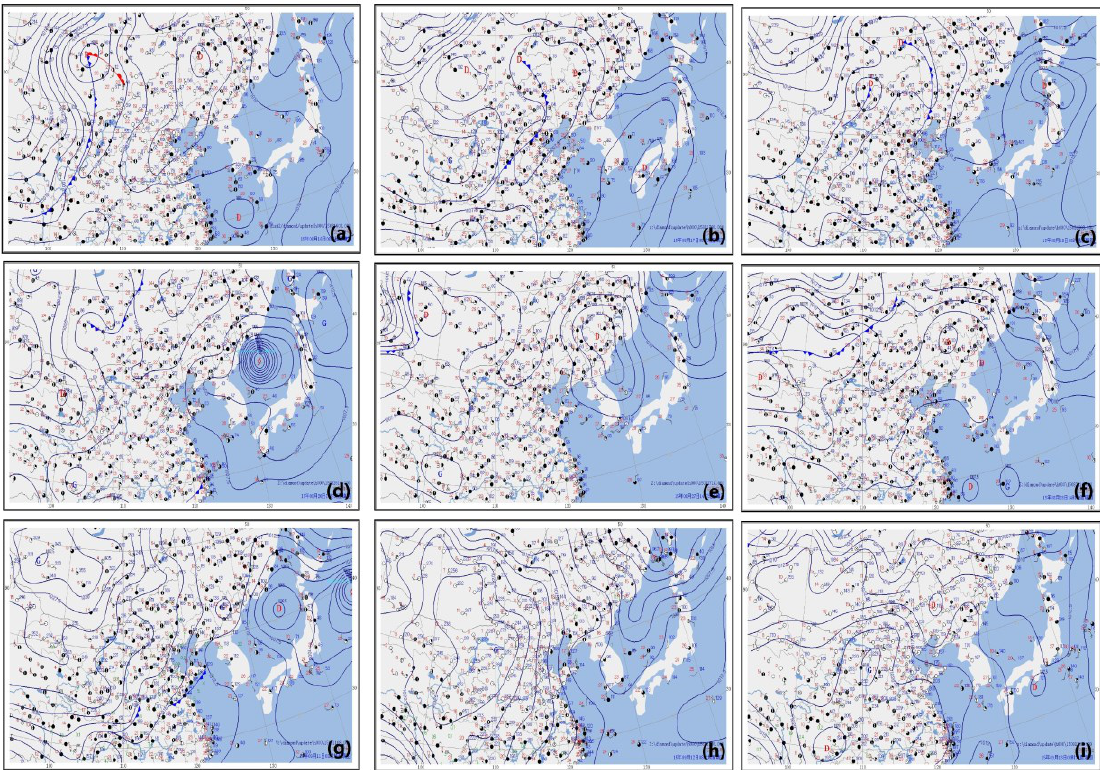
Figure 9. Surface weather situation at 08:00 ( a – c ) on 16–18 August; 14:00 ( d – f ) on 26–28 August; and 08:00 ( g – i ) on 11–13 September in the Beijing area.